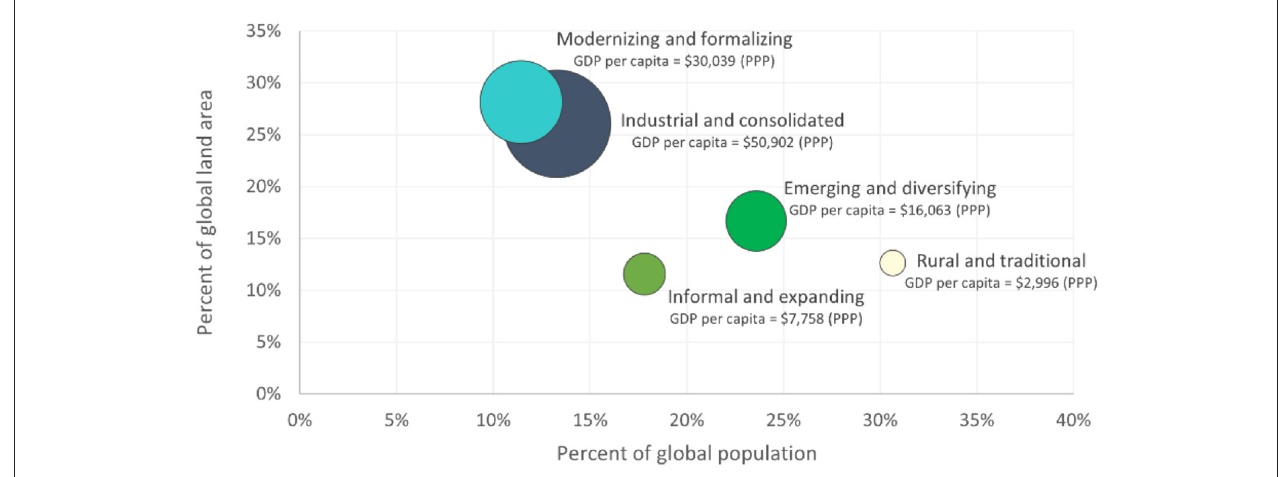
FIGURE 3 | Population, land share, and GDP per capita by food system type.